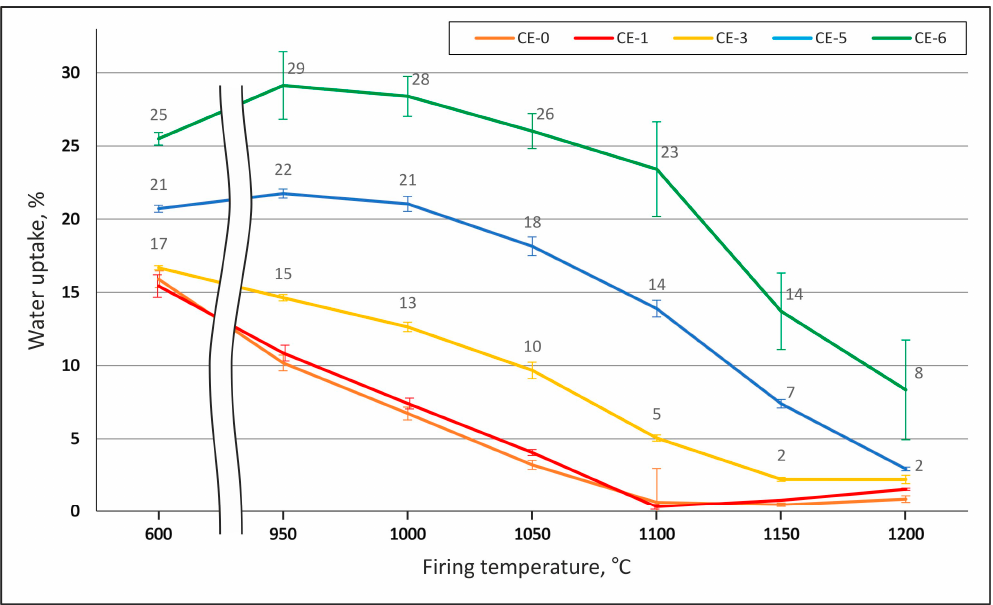
Figure 6. Apparent density dependence on the CS content and the firing temperature.